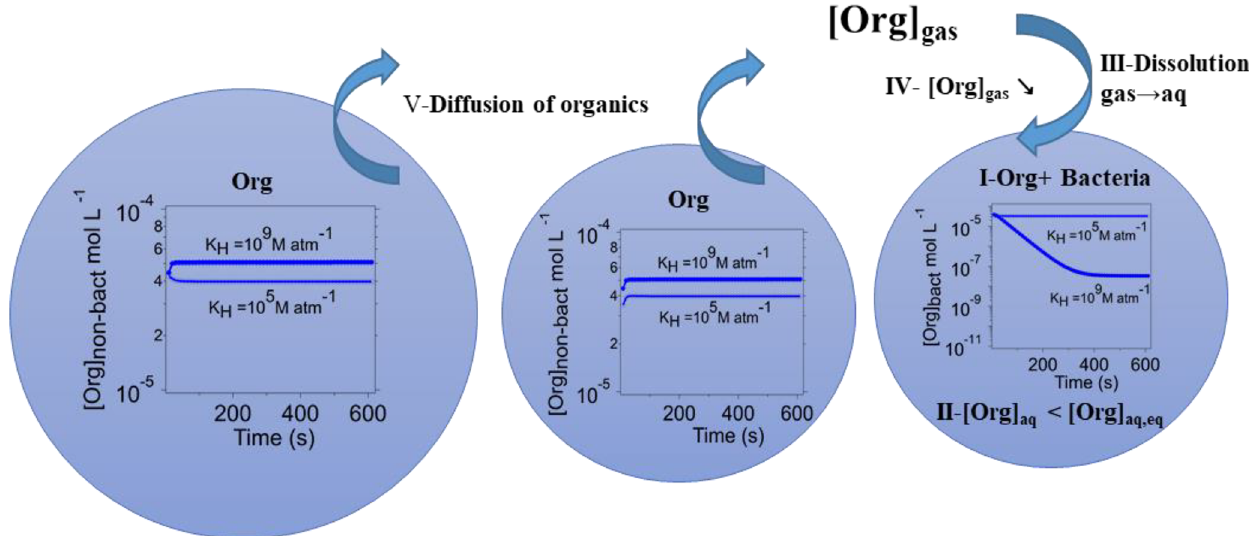
Figure 5. Schematic of the partitioning of water-soluble organic gases between the bacteria-containing and bacteria-free droplets and the gas phase: the inset figures show the temporal evolution of the organic concentration in the bacteria-containing droplets ([Org] bact ) and bacteria-free droplets ([Org] non − bact ) for water-soluble organic gases with K H = 10 5 and 10 9 Matm − 1 .